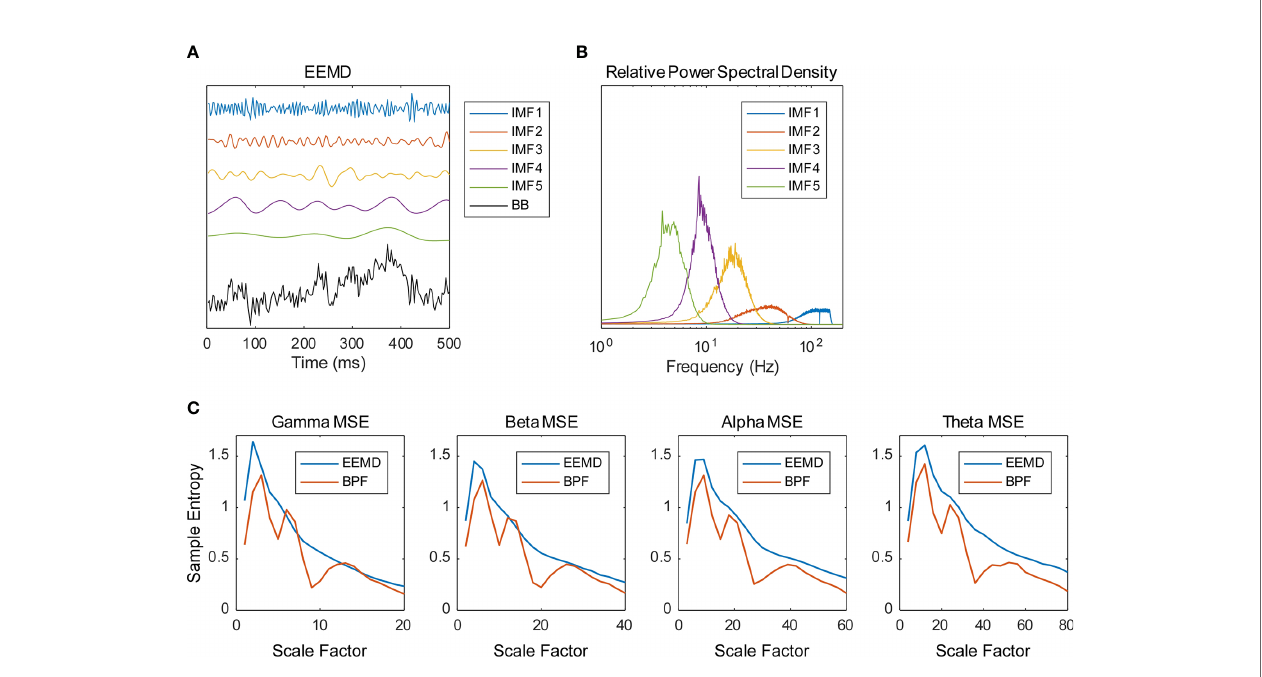
FIGURE 1 | Frequency decomposition by ensemble empirical mode decomposition (EEMD). (A) Example of the source time series calculated from magnetoencephalography (MEG) data decomposed into fi ve intrinsic mode functions (IMFs) using the EEMD (BB, broadband). (B) Example of the relative power spectral densities of the decomposed time series. (C) Multiscale entropy (MSE) pro fi les obtained using EEMD and bandpass fi lter (BPF). Source time series were decomposed into four frequency bands using EEMD (IMF 2 – 5) and BPF (gamma, 33 – 55 Hz; beta, 16 – 27 Hz; alpha, 8 – 14 Hz; theta, 4 – 7 Hz). Examples of spectral MSE of a healthy control (HC) subject averaged within the temporal regions are shown (gamma — 1, 2, 3, … , 20 SF; beta — 2, 4, 6, … , 40 SF; alpha — 4, 8, 12, … , 80 SF; theta — 8, 16, 24, … , 160 SF). The BPF-based spectral MSEs showed multiple peaks, whereas the EEMD-based spectral MSE showed a single